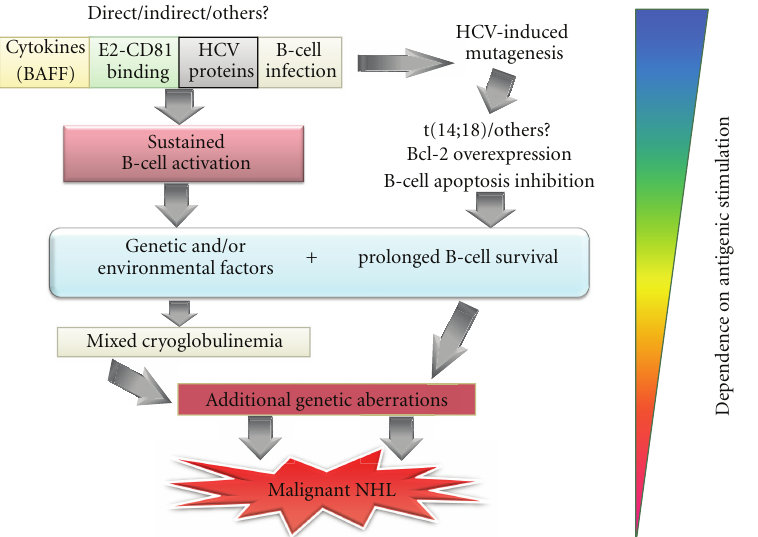
Figure 2: HCV-related LPD pathogenesis is a multifactorial and multistep process. Current data suggest that the starting points of this process are represented by the cooperation between a sustained and persistent stimulation—by direct or indirect action of viral particles or proteins—and antiapoptotic mechanisms acting on B-cell compartment. A predisposing genetic background would be responsible for the final evolution to a particular LPD (namely, MC). The progressive addition of genetic aberrations would lead to a frank neoplastic transformation, gradually making the process less dependent on the etiologic